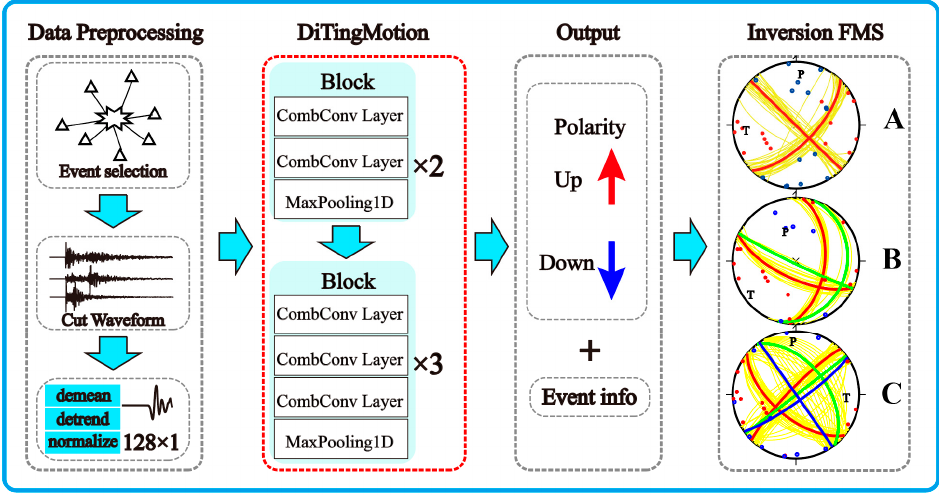
Figure 1. FocMech-Flow flow chart for focal mechanism inversion. A, B and C represent three levels of reliability of the focal mechanism solution. A is the best, B is the second, and C is the worst. P and T are the pressure axis and tension axis, respectively.